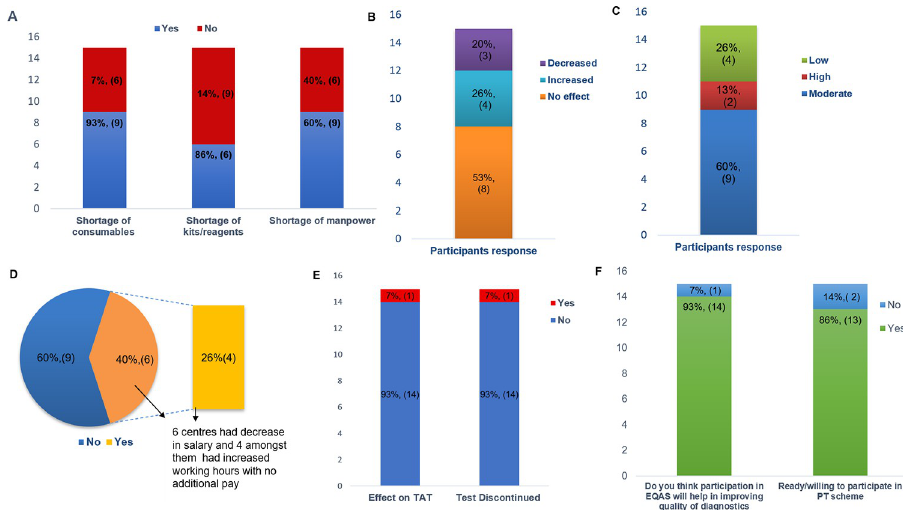
Fig 2. Survey response data from various participating centres depicting the impact of pandemic on routine diagnostics (A)Effect on kits, consumables and manpower (B) Effect on volume of test requisitions (C) Effect on revenue generated from diagnostics (D) Effect on work profile and pay (E) Effect on Turn-around time (TAT) for testing and discontinuation of tests (F) Response for participation in EQAS scheme.